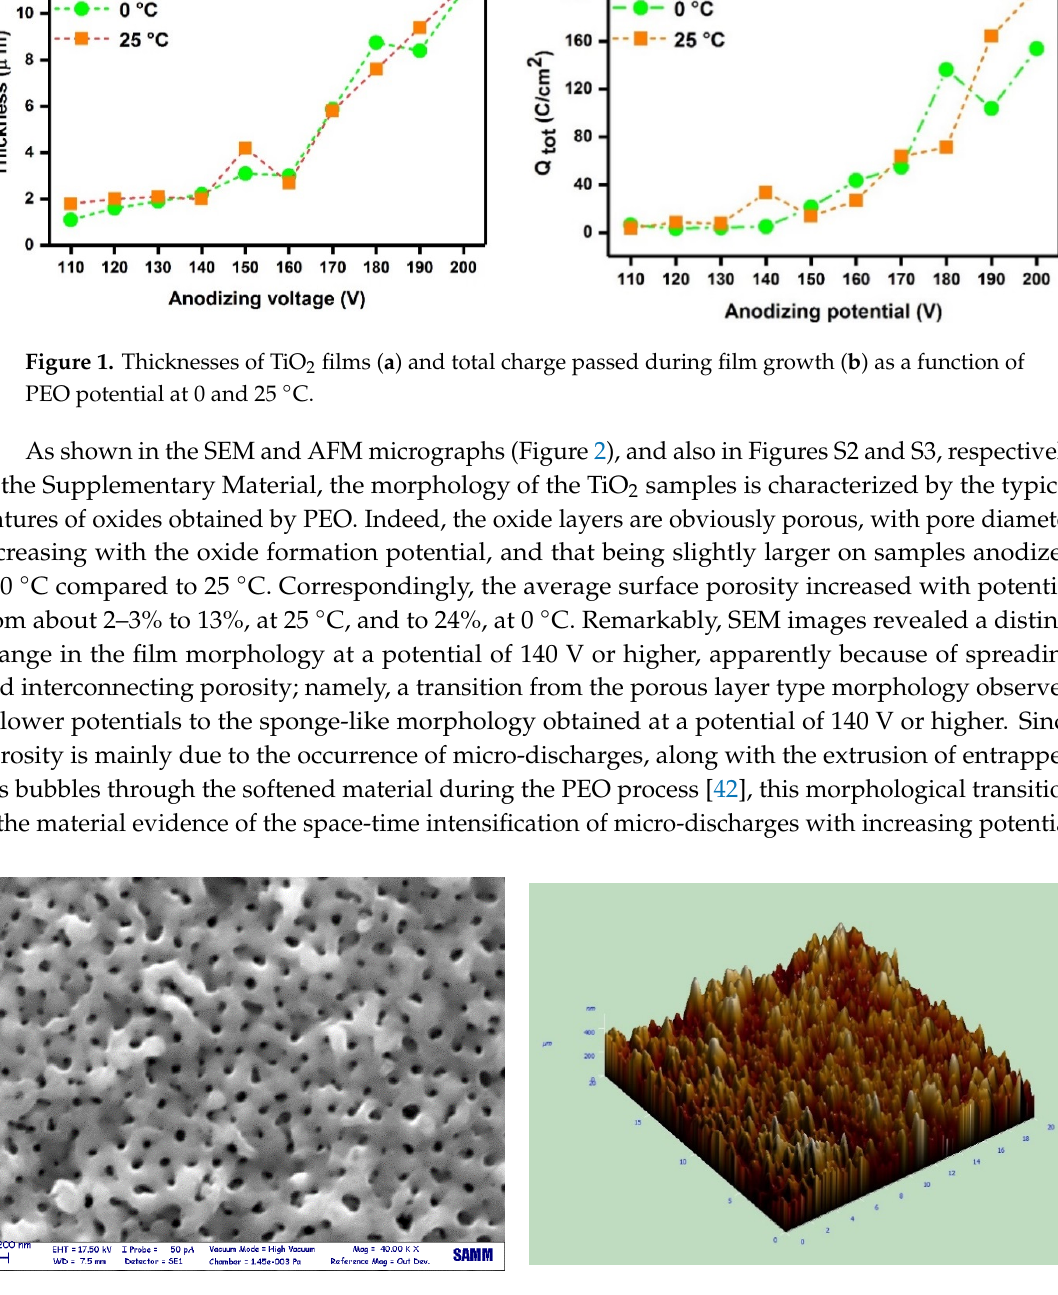
Figure 2. SEM micrograph (left) and AFM image (right) of a typical TiO 2 film obtained at 140 V at 0 °C.